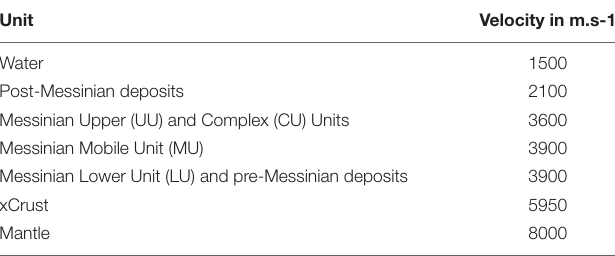
TABLE 1 | Velocity model used for the depth conversion.